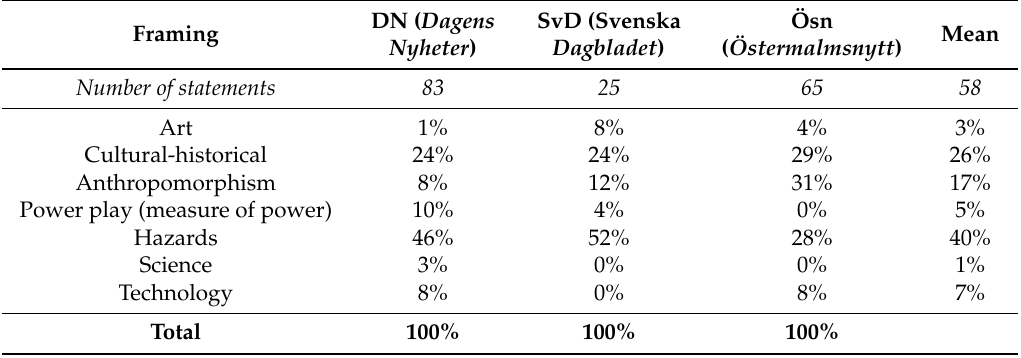
Table 4. Number of statements in each newspaper and framing of the statements, shown as a percentage for each